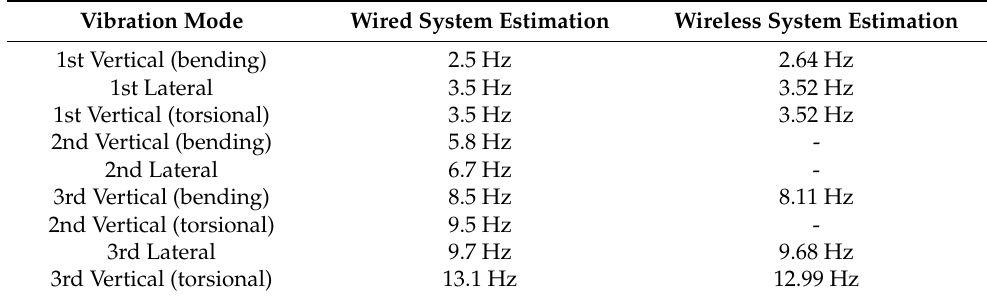
Table 4. Comparison between natural frequencies estimated by the wired and wireless monitor- ing